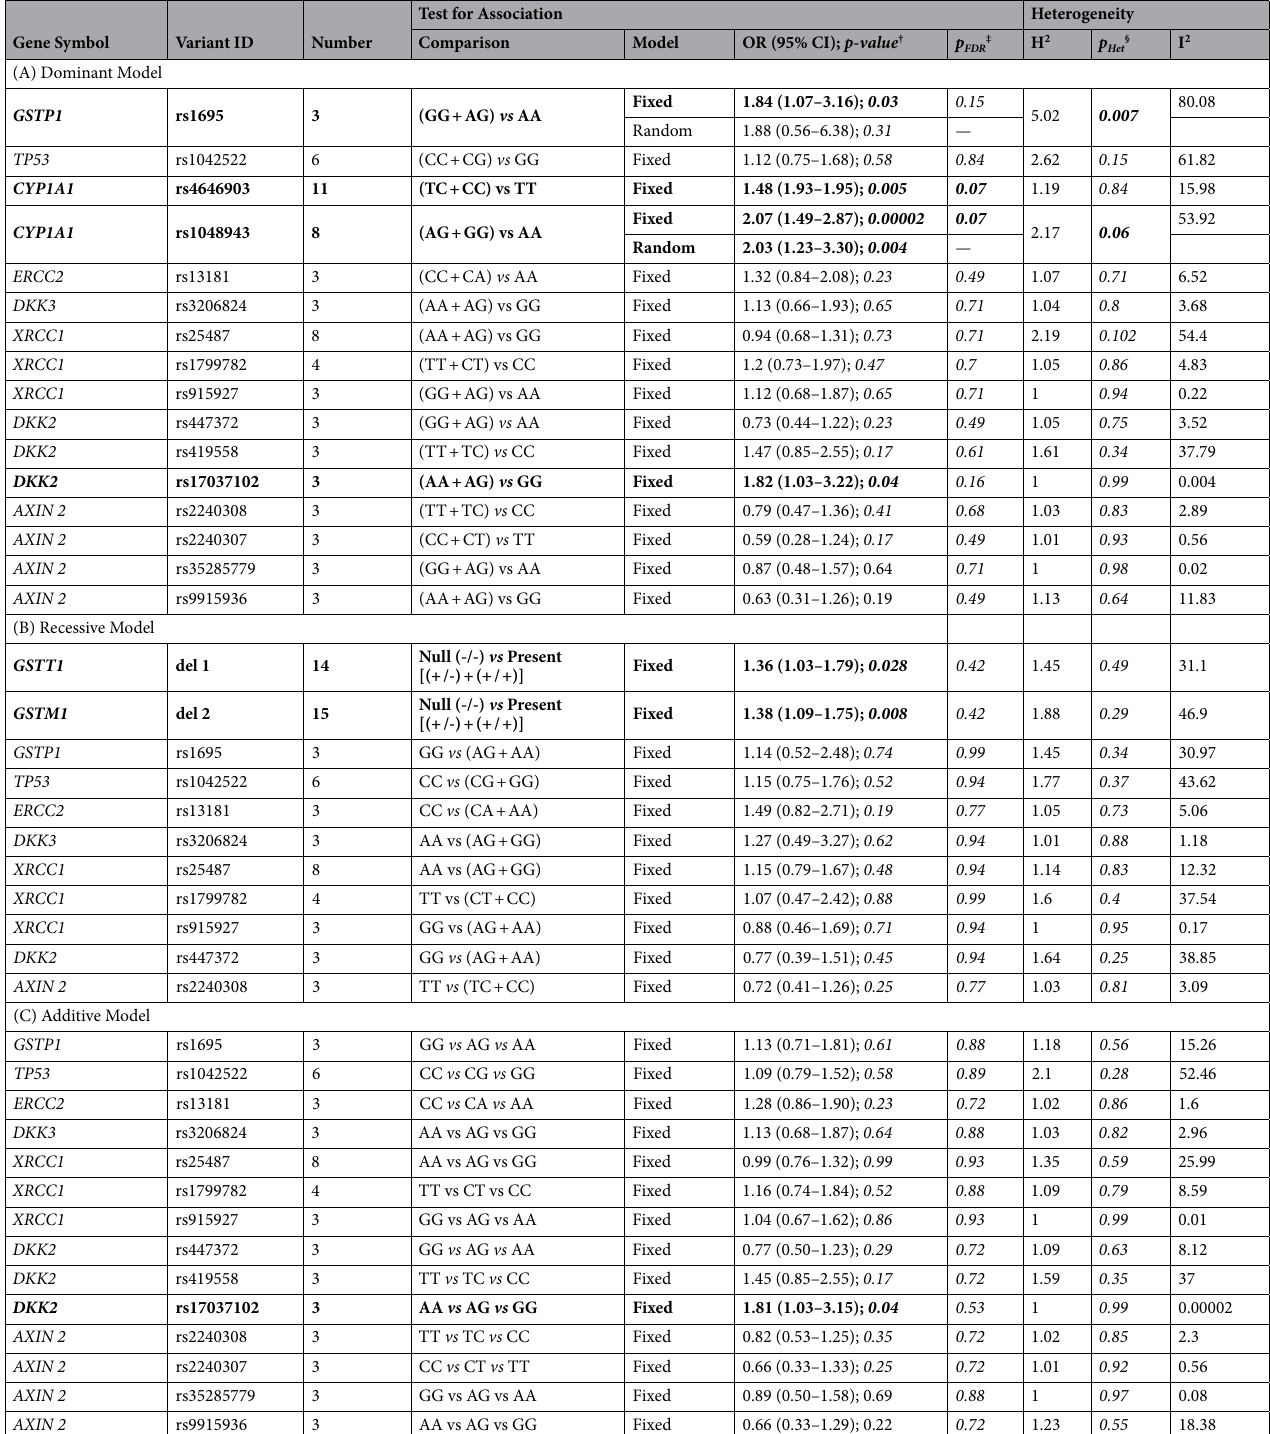
Table 2. A comprehensive list of meta-analysis results showing the overall association of the variants with lung cancer, with crude odds ratio (OR), 95% Confidence Interval (CI), p FDR , Benjamini-Höchberg